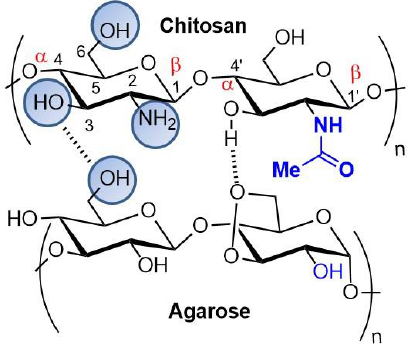
Figure 8. Chitosan and agarose scaffolds.